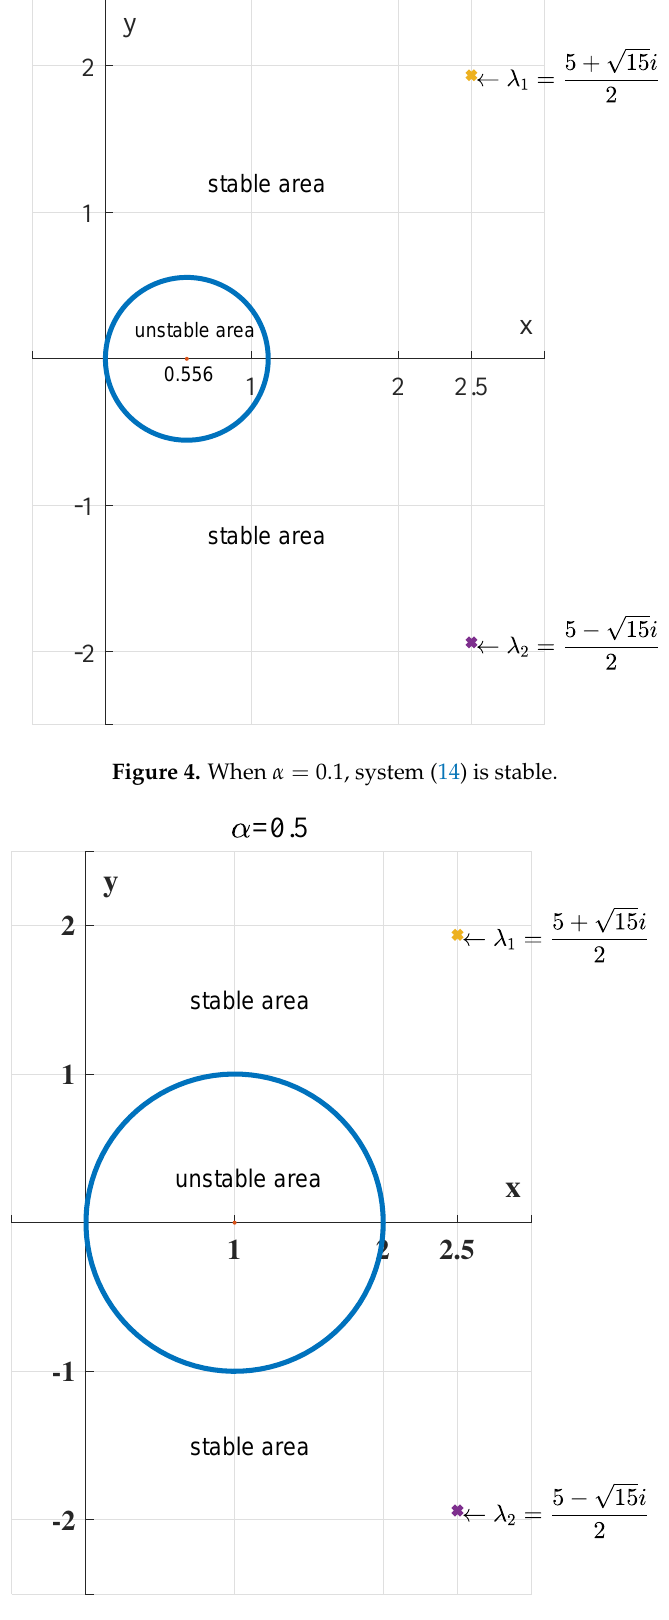
Figure 5. When α = 0.5, system (14) is